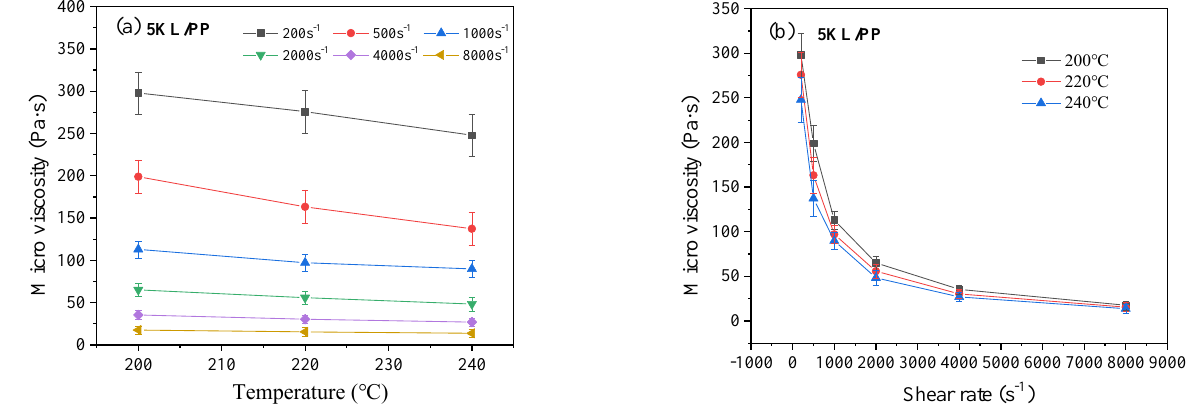
Figure 1. Microviscosities of the 5KL/PP composite at different ( a ) temperatures and ( b ) shear rates.